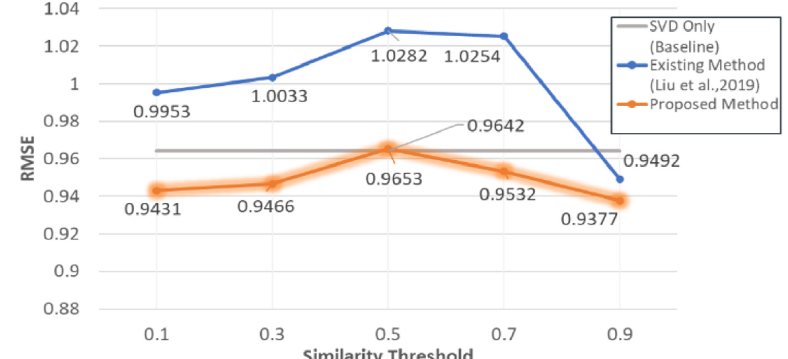
Figure 4. RMSE comparison with different similarity threshold and methods.